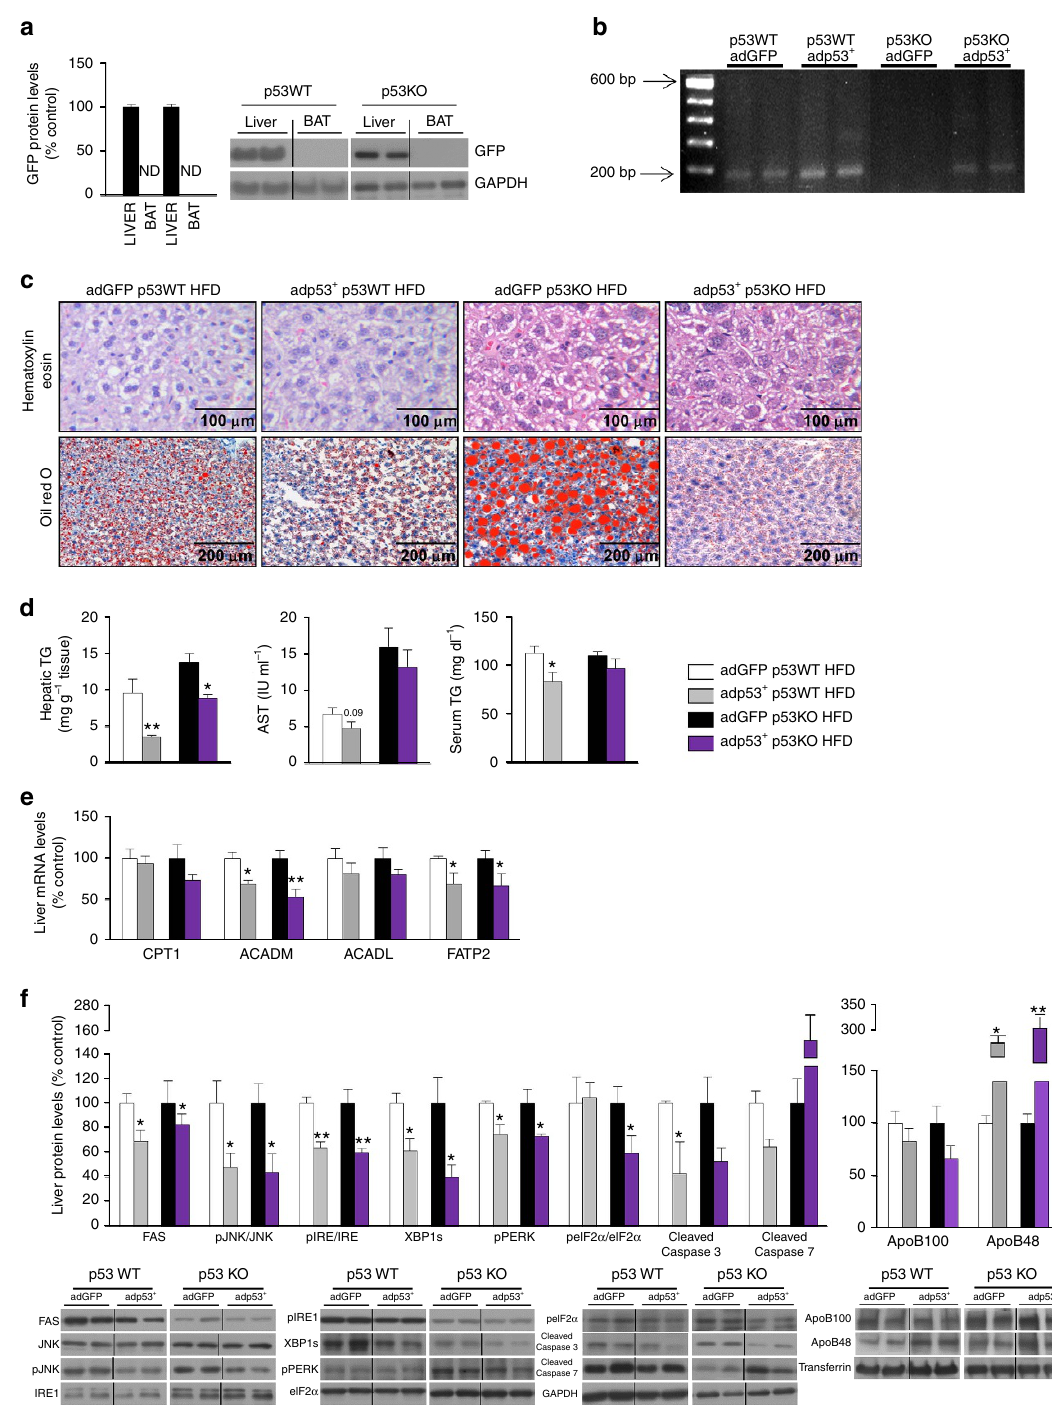
Figure 2 | Hepatic rescue of p53 in mice fed a high fat diet ameliorates steatosis of global p53 null mice. ( a ) GFP protein levels in the liver and brown adipose tissue (BAT) of WT and p53 null mice after a tail vein injection of adenoviruses encoding either GFP or p53 ( n ¼ 5 per group). ( b ) p53 gene expression in the liver of WT and p53 null mice after the injection of adenoviruses encoding either GFP or p53. ( c ) Representative photomicrographs of hematoxylin-eosin (upper panel) and oil red O staining (lower panel) of mice liver sections ( n ¼ 3 per group); ( d ) total liver TG content, serum ASTand TG levels ( n ¼ 6 GFP and 5 p53 in WTmice; n ¼ 5 GFP and 4 p53 in KO mice); ( e ) mRNA expression of CPT1, ACADM, ACADL and FATP2; and ( f ) protein levels of FAS, pJNK/JNK, pIRE/IRE, XBP1s, pPERK, peIF2 a /eIF2 a , cleaved caspase 3, cleaved caspase 7, ApoB100 and ApoB48 in the liver of WTand p53 null mice fed a HFD after the over-expression of hepatic p53. Western blots were performed separately in WTand p53 null mice, and the values of Ad GFP mice were always set to 100% ( n ¼ 5 GFP and p53 in both WT and p53 null mice). GAPDH or transferrin were used to normalize protein levels. Dividing lines indicate splicings in the same gel. Uncropped blots of this Figure accompanied by the location of molecular weight markers are shown in Supplementary Fig. 11. Data are presented as mean ± standard error mean (s.e.m.). Statistical significance, * P o 0.05 and ** P o 0.01, was tested using Student t -test comparing WT and KO mice. ND: non